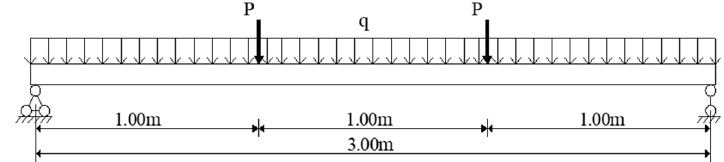
Figure 12. Load placement in the experiment.